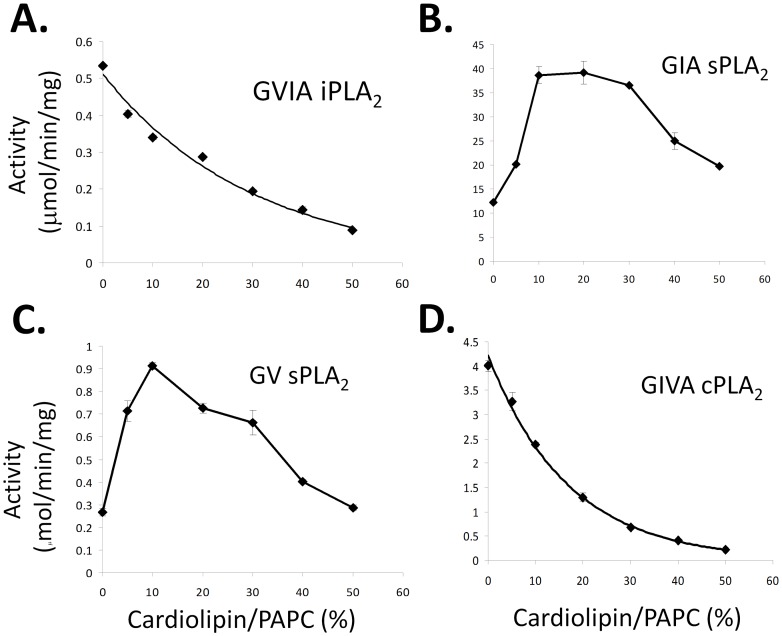
Cardiolipin Effects on PLA2 Activity toward PAPC.The in vitro mixed micelle assay was utilized to determine if cardiolipin affects the enzymatic activities of A. GVIA iPLA2, B. GIA sPLA2, C. GV sPLA2, and D. GIVA cPLA2 toward PAPC. Mixed micelles composed of 100 µM phospholipid and 400 µM Triton X-100 was employed as substrate containing the mole % of cardiolipin to PAPC indicated.